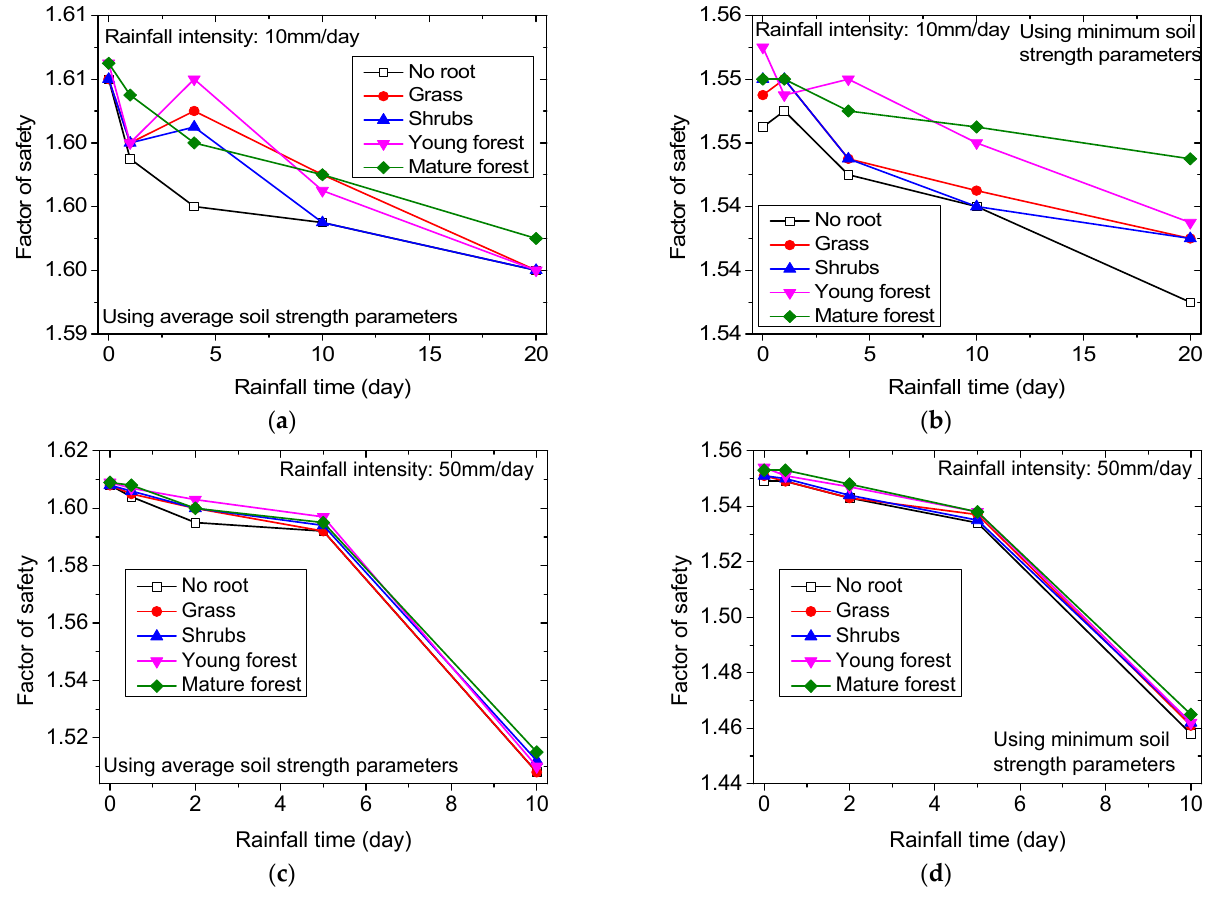
Figure 11. Factor of safety of the slope with different rainfall conditions and soil strength parameters: ( a ) 10 mm/day rainfall and average soil strength parameters; ( b ) 10 mm/day rainfall and minimum soil strength parameters; ( c ) 50 mm/day rainfall and average soil strength parameters; ( d ) 50 mm/day rainfall and minimum soil strength parameters.